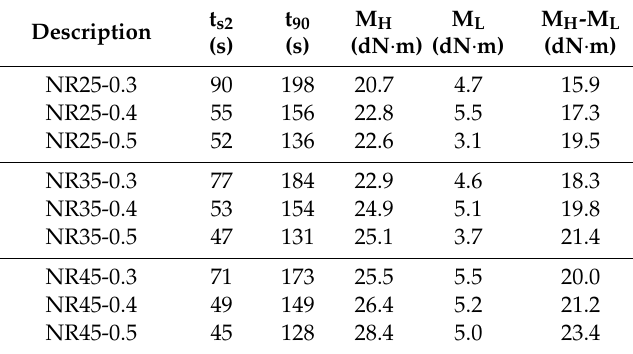
Table 3. Curing characteristics of the NR